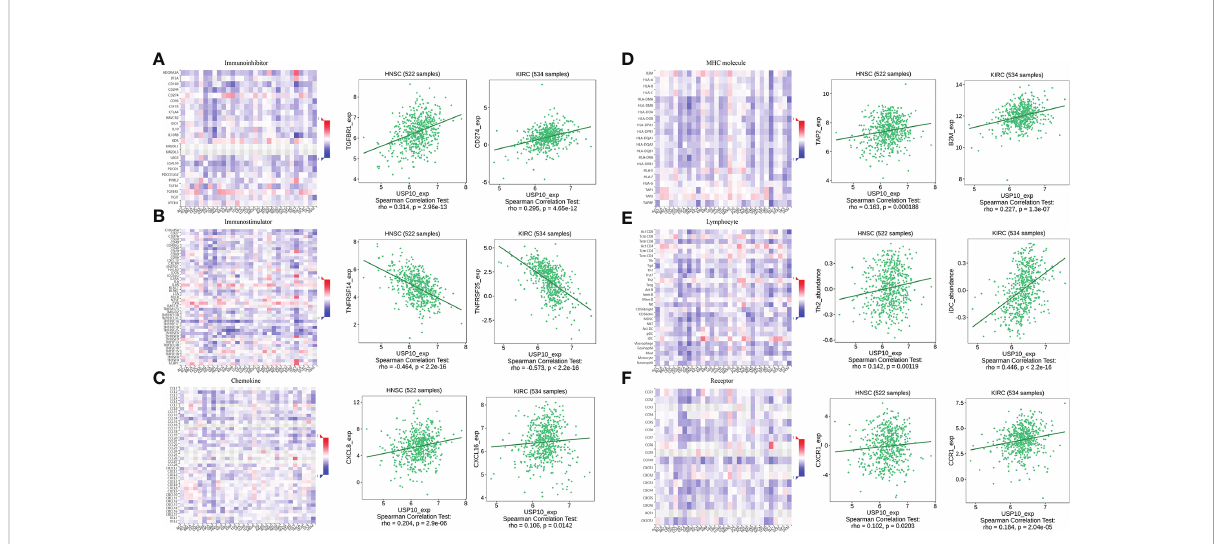
FIGURE 4 USP10 was positively correlated with immunosuppressive molecules (A) , immunostimulatory molecules (B) , chemokines (C) , MHC molecules (D) , lymphocytes (E) , and MHC receptors (F) . USP10, Ubiquitin-speci fi c peptidase 10; MHC, major histocompatibility